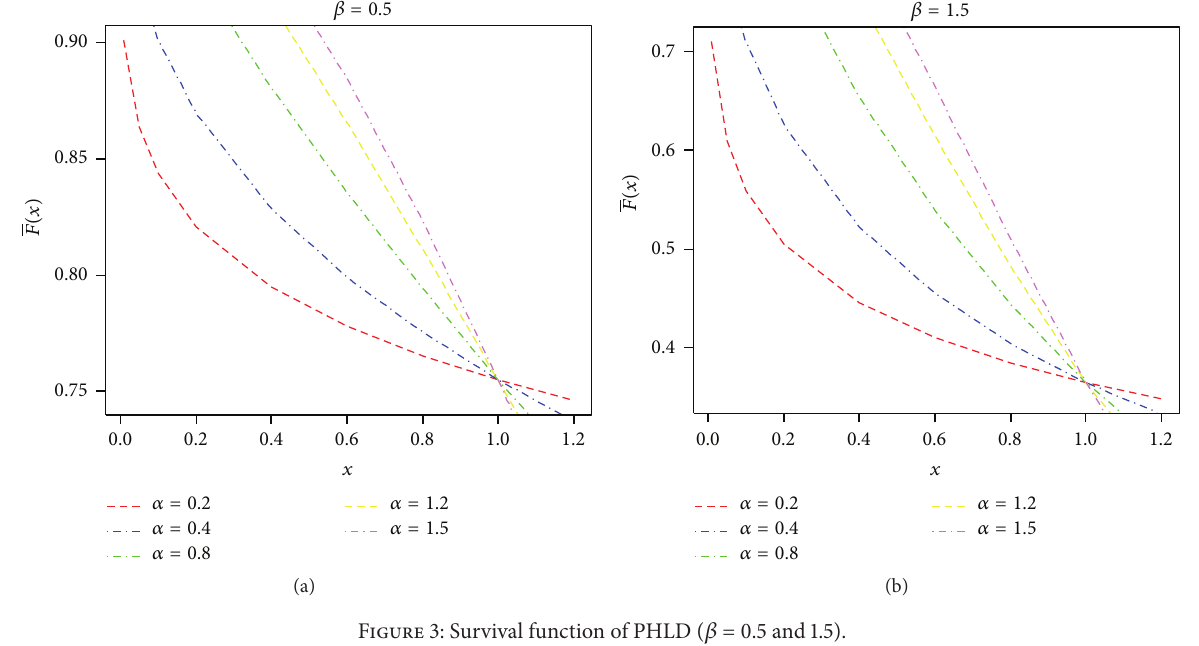
Figure 3: Survival function of PHLD ( 𝛽 = 0.5 and 1.5).